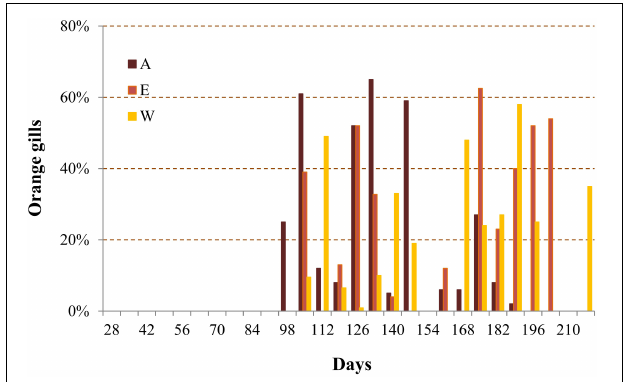
FIGURE 2 | Temporal variations of orange gill percentage in the shrimp population of the three studied ponds (Ponds A, E, and